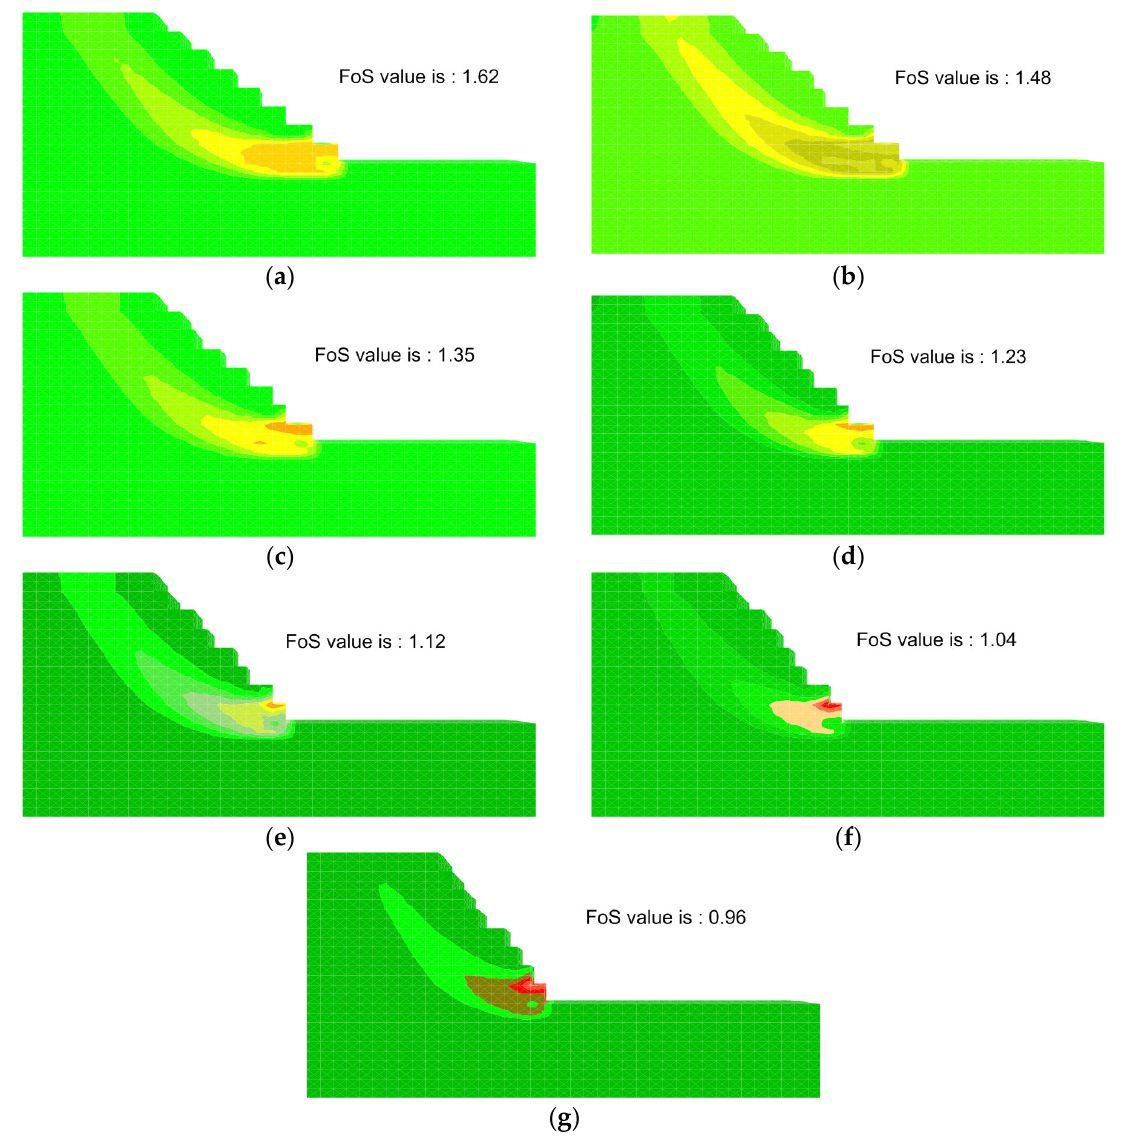
Figure 10. Safety factor corresponding to different slop angles when the aging parameter deteriorates by 5%. ( a ) α = 36°; ( b ) α = 38°; ( c ) α = 40°; ( d ) α = 42°; ( e ) α = 45°; ( f ) α = 48°; AND ( g ) α = 51°. In the same way, the F s of seven slope forms can be obtained when the aging parameters of slope are deteriorated by 10%, 15%, 20%, and 0%. Considering that the damage of rock is a progressive failure process, and the degradation rate is inconsistent in different periods, the classical Freundlich model is selected to fit the heterogeneous degradation process. The fitting curves are shown in Figure